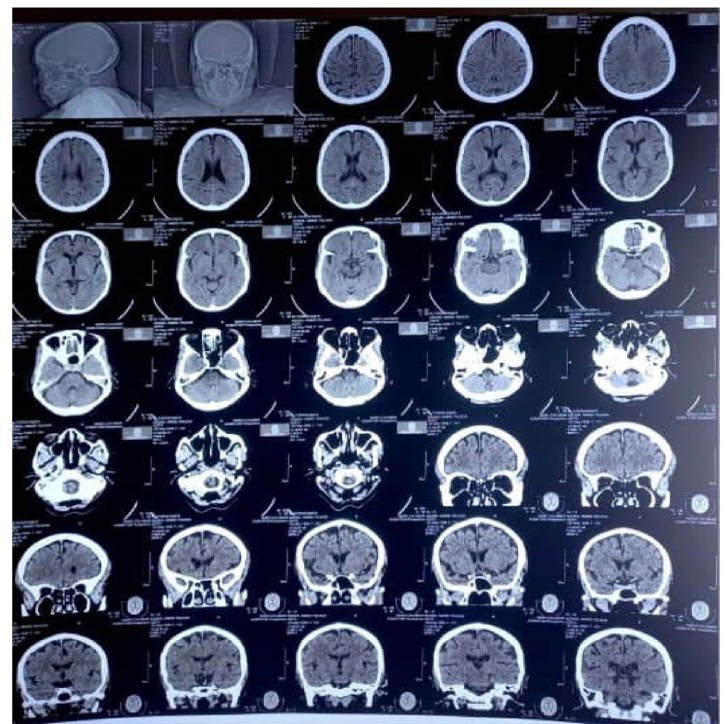
Fig. 2 Cranial CT scan showing mild age-related cerebral atrophy, no focal intracerebral, or intracerebellar mass lesion